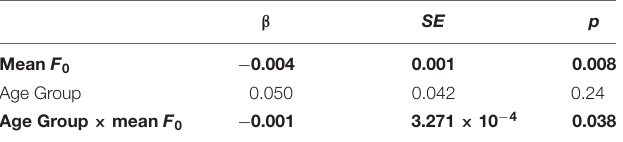
TABLE 5 | Fixed effect estimates of the best-fitting models of performance for the group comparison of the valence data; bold indicates significant results, number of observations = 1332, AIC = 1415.